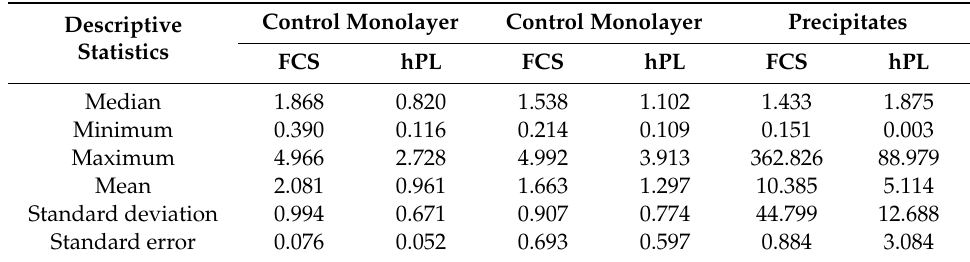
Table 3. Descriptive statistics of Young’s moduli in untreated (control) and osteogenic monolayers and of calcium phosphate precipitates in FCS / hPL groups.Medians with minimum and maximum, means, standard deviations and standard errors of mean are